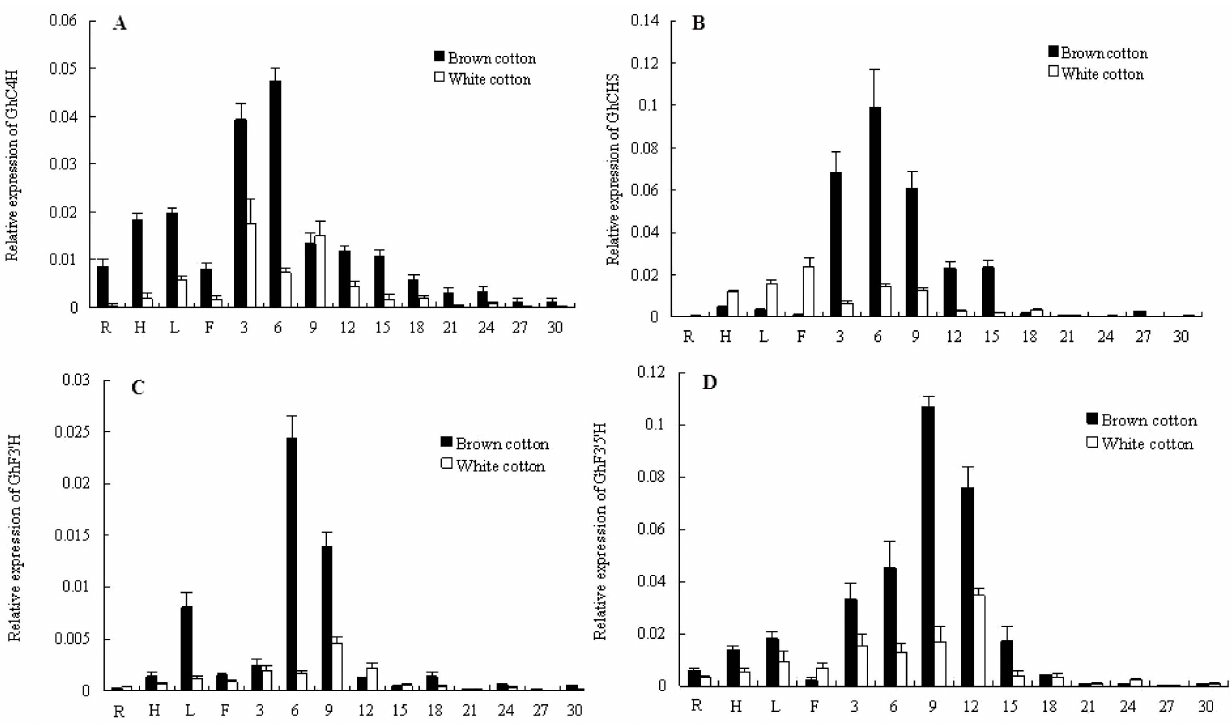
Figure 5. QRT-PCR analysis of four flavonoid structural genes in the brown and white cotton. A: GhC4H1 , B: GhCHS , C: GhF3 9 H , D: GhF3 9 5 9 H . In the horizontal axis, 1: roots; 2: hypocotyls; 3: leaves; 4: flowers, 5–14 represent 3, 6, 9, 12, 15, 18, 21, 24, 27, 30 DPA fiber cells, respectively.